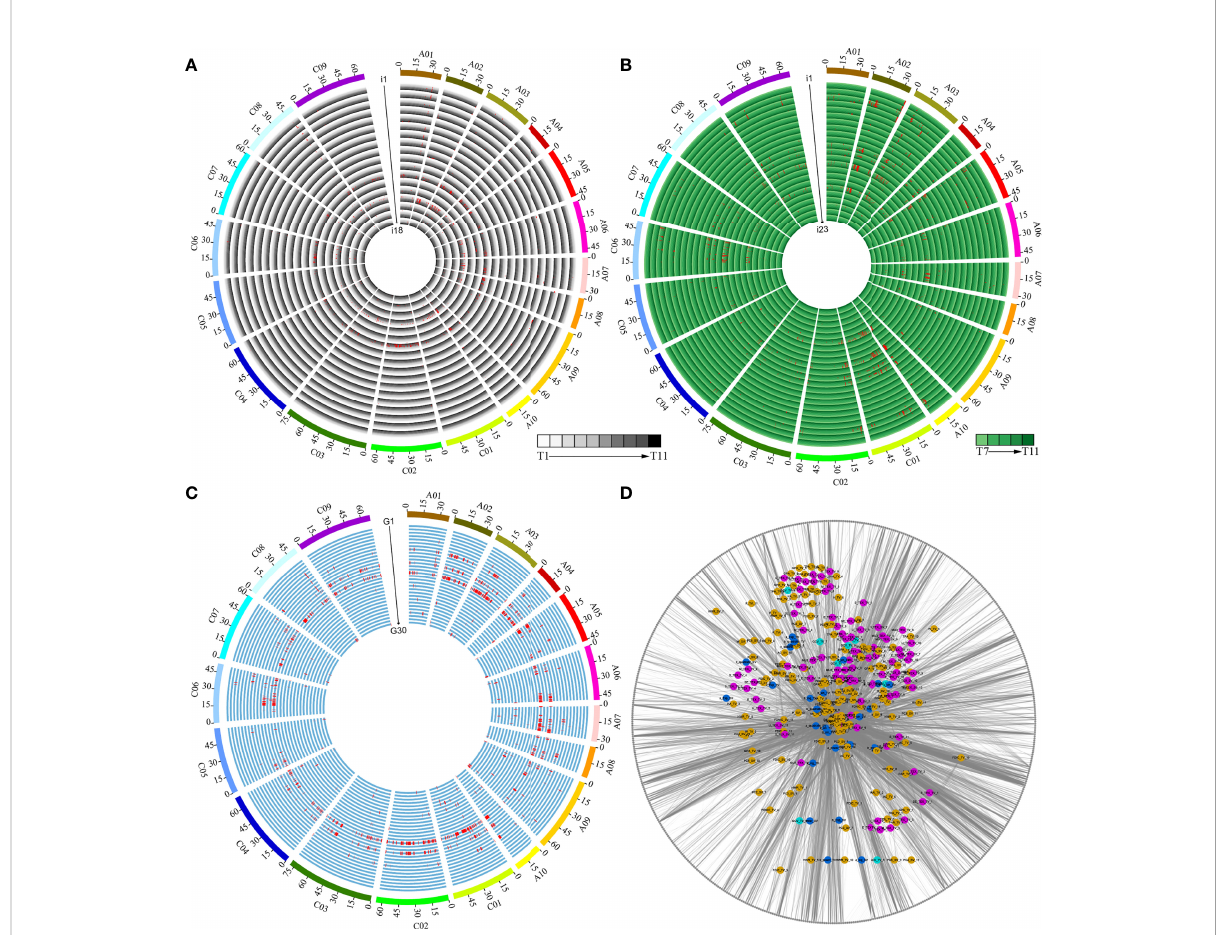
FIGURE 5 Dynamic QTLs detected in the population by GWAS. (A) QTLs responsible for the 18 i-traits in top view. i1-i18 represent GCV_TV, M_TEX_TV, SE_TEX_TV, S_TEX_TV, MU3_TEX_TV, U_TEX_TV, E_TEX_TV, TPA_TV, H_TV, W_TV, HWR_TV, FDNIC_TV, FDIC_TV, R_TV, PAR_TV, HA_TV, AC_TV, and GPA_TV, respectively. (B) QTLs responsible for the 23 i-traits in side view. i1-i23 represent M_TEX_SV, SE_TEX_SV, S_TEX_SV, MU3_TEX_SV, U_TEX_SV, E_TEX_SV, TPA_SV, H_SV, W_SV, HWR_SV, FDNIC_SV, FDIC_SV, R_SV, PAR_SV, HA_SV, AC_SV, GPA_SV,